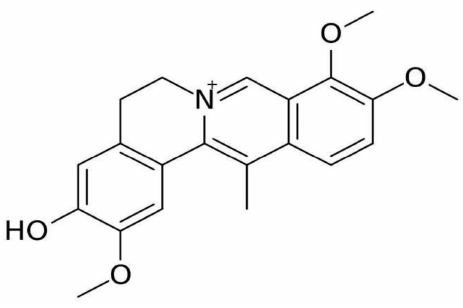
Figure 3. Chemical structure of